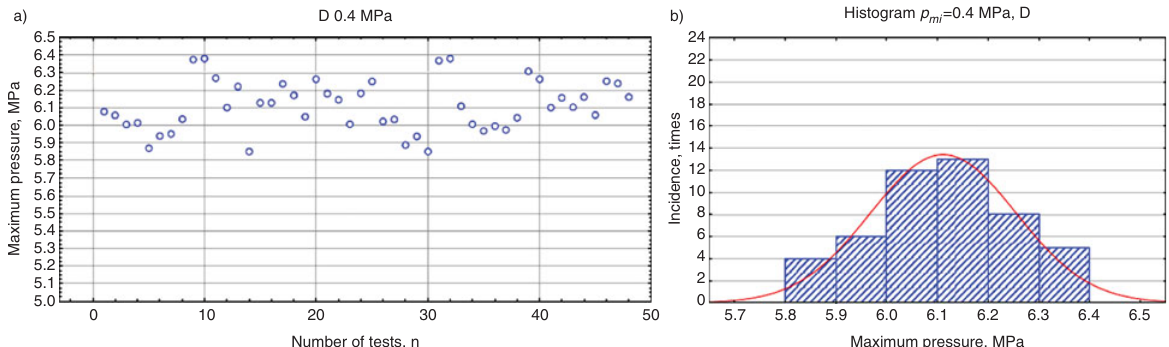
Fig. 7. Statistical analysis of cyclic instability of engine working on mineral diesel